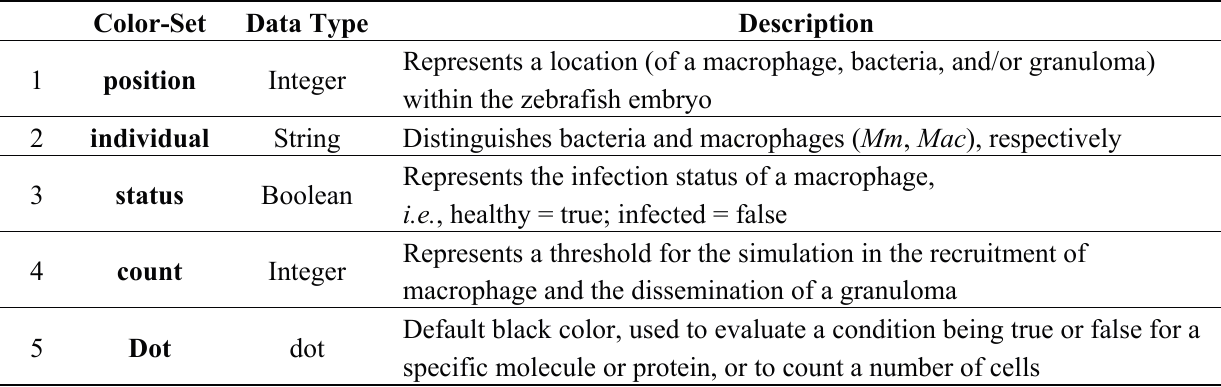
Table 1. Simple color-sets defined for the colored Petri net model.